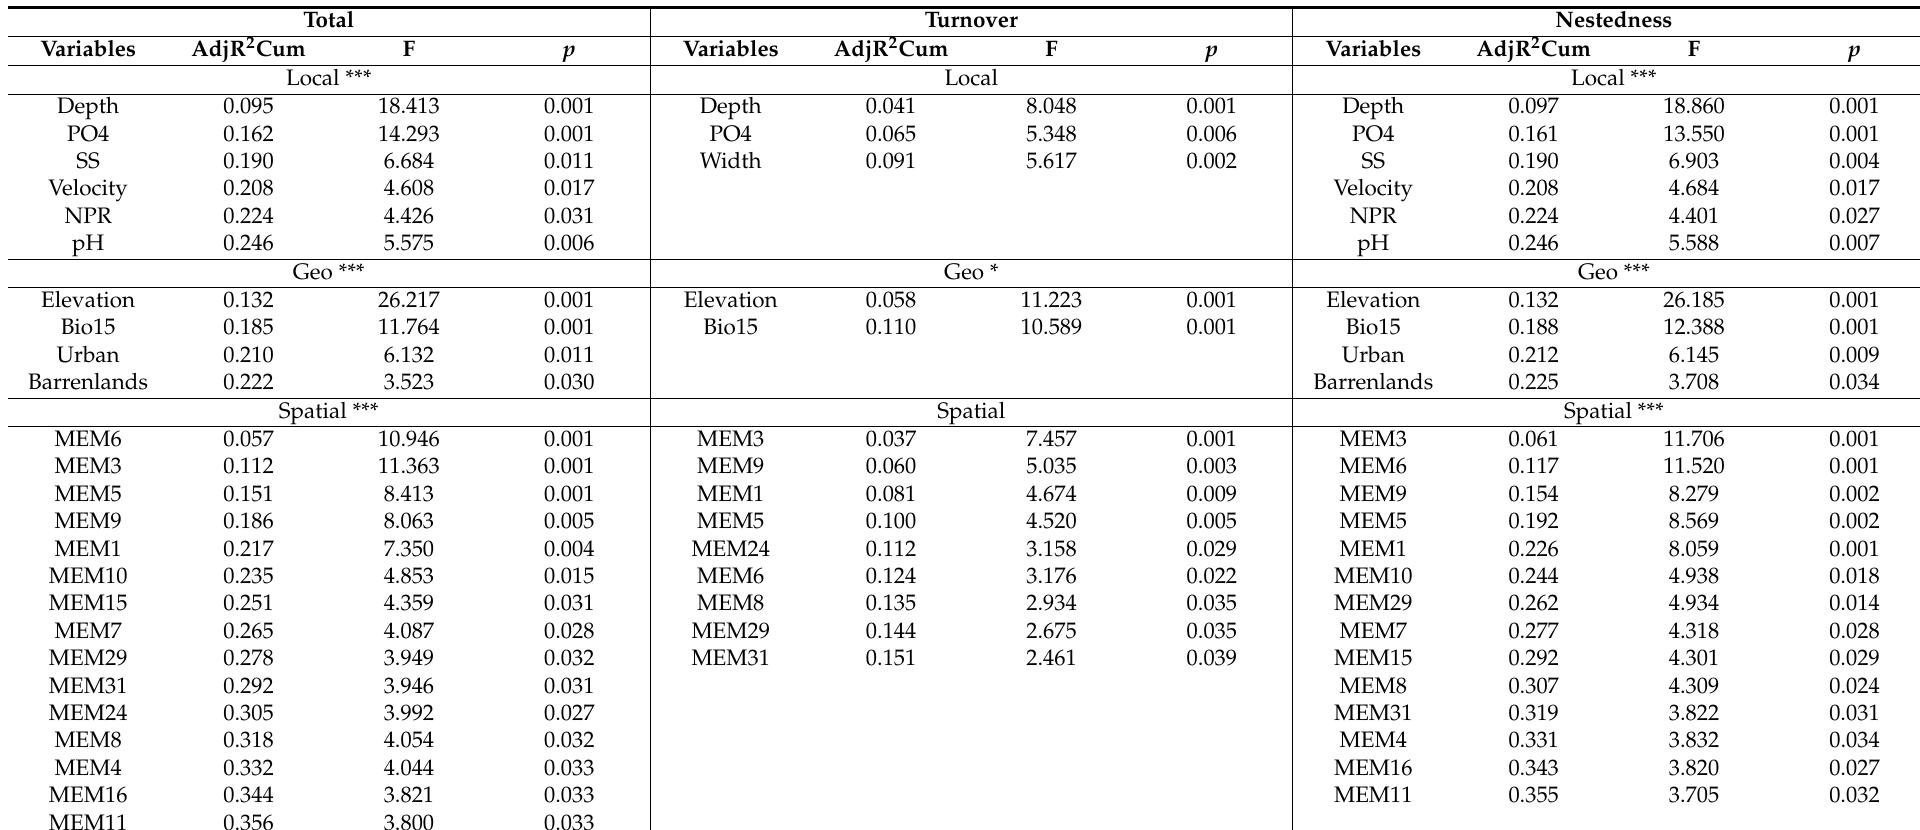
Table 3. The local environmental (Local), geo-climatic (Geo), and spatial (Spatial) variables that were selected for the functional β -diversity component, respectively. Each variable is displayed in the order in which it was selected. F, p, and AdjR 2 Cum values are displayed. None of the selected variables showed